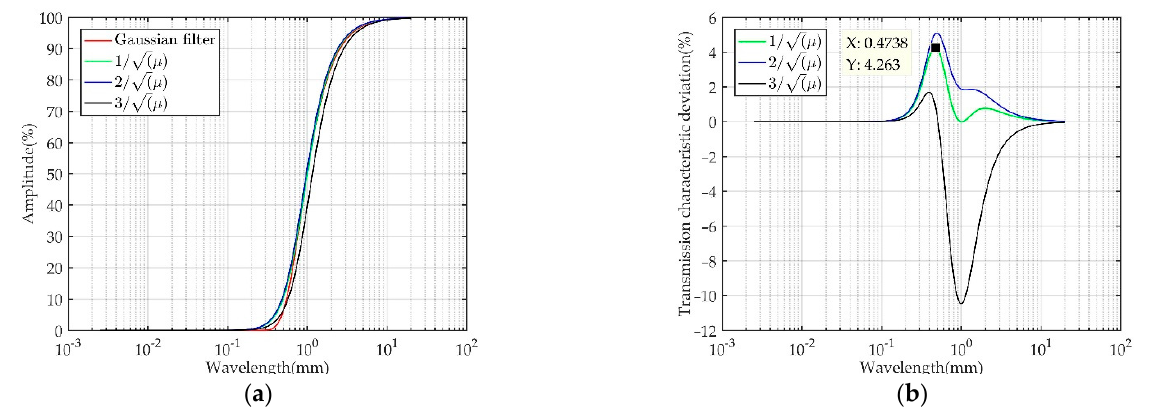
Figure 2. ( a ) Transmission characteristics and ( b ) transmission characteristic deviation of the approximating spline filter τ = 1/ µ , 2/ µ , and 3/ µ , and Gaussian